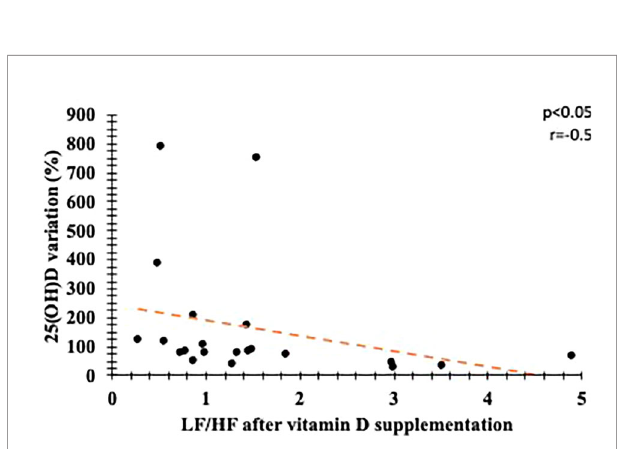
FIGURE 7 | Correlation between percentage variation in serum vitamin D levels and fi nal LF/HF. LF, Low frequency ; HF, High frequency